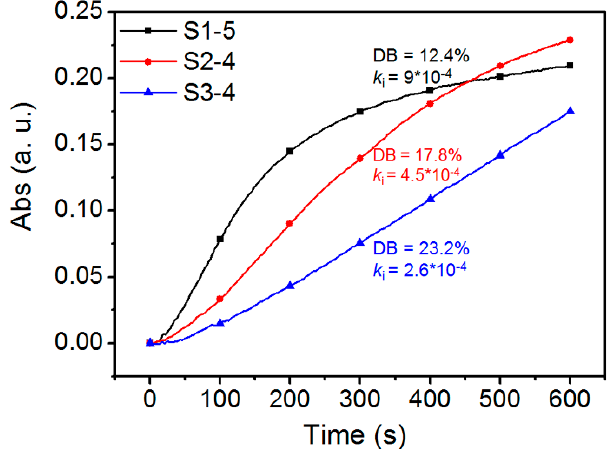
Figure 3. Time course of turbidity towards the binding behavior between Con A and HPManEMA- co -MBA ( M n = 2.7 × 10 4 Dalton ) at 25 °C. The concentration of Con A was 1 μ M, and the concentration of ManEMA unit was adjusted to be 500 μ M for each sample.